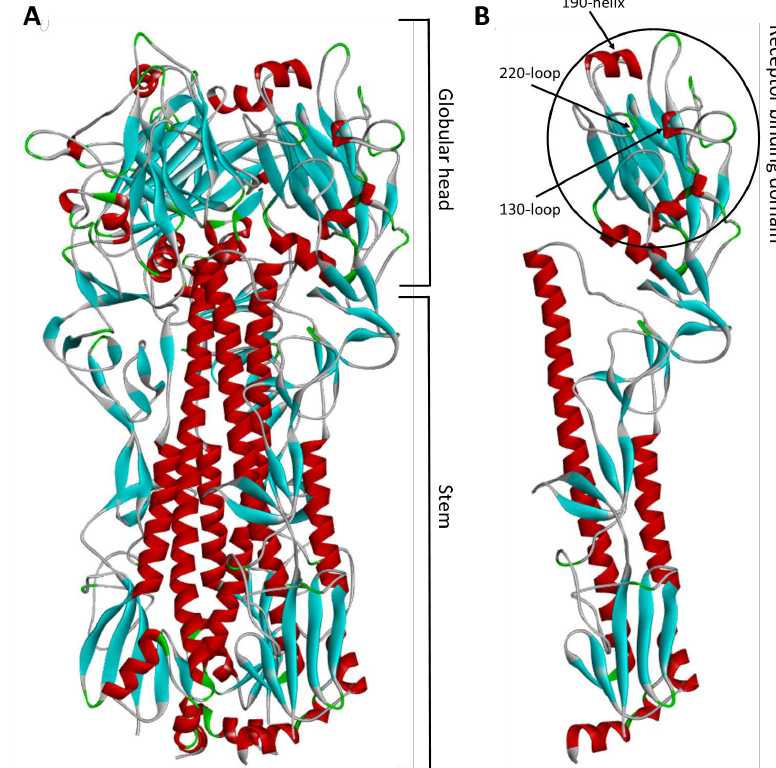
Figure 5. Protein homology model of influenza A virus haemagglutinin. Protein homology model of A/Puerto Rico/8/1934 (H1N1) (NCBI: ABO21709), based on the crystal structure of 1HA0 [156]. ( A ) Haemagglutinin trimer. ( B ) Haemagglutinin protomer. Protein homology model was generated with SWISS-MODEL [157–159], and visualized in Discovery Studio (Dassault System è s